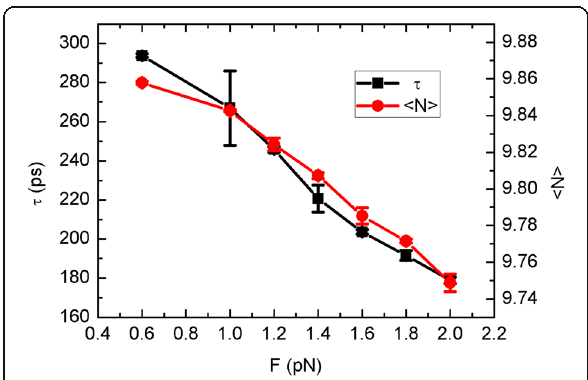
Fig. 7 The translocation time τ and occupancy < N > as a function of the driving force